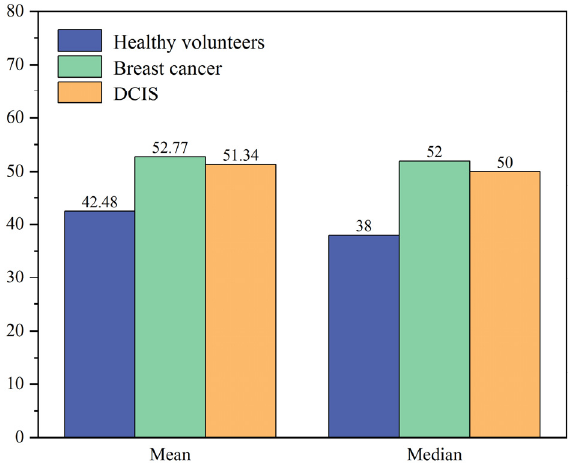
Figure 1. The age information of healthy volunteers, breast cancer and DCIS patients.